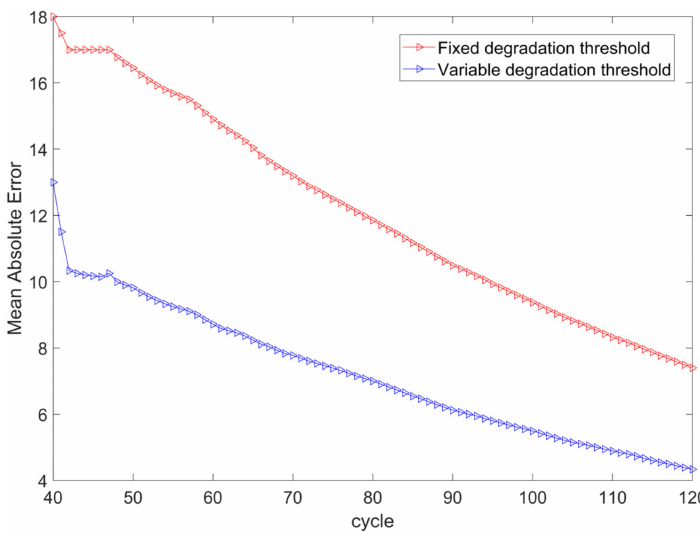
Figure 12. MAE between the estimated RUL and the true RUL.